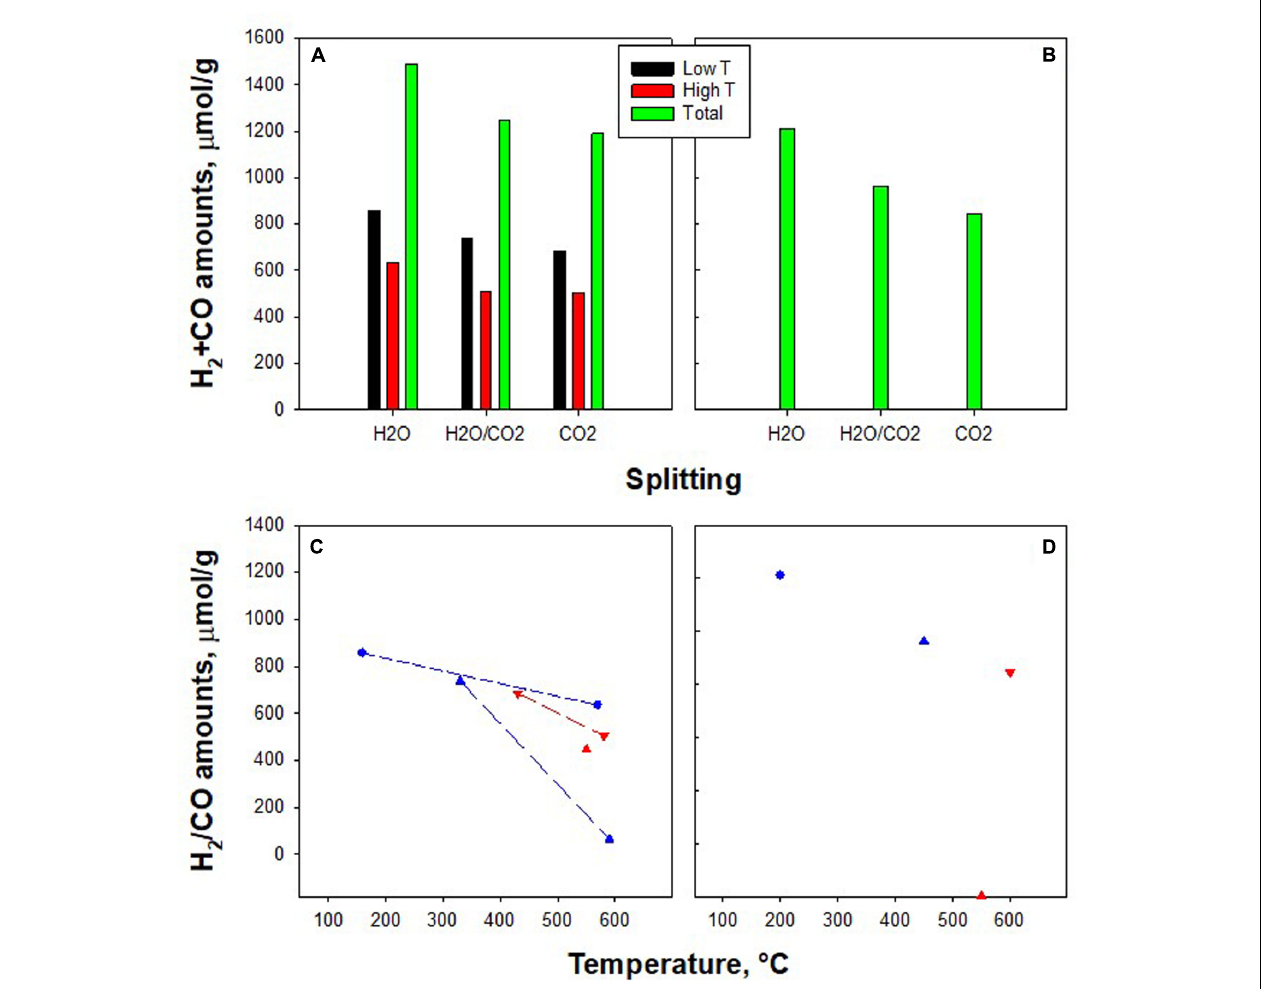
FIGURE 2 | Quantitative analysis of splitting tests under different oxidants. Partial and overall amounts of H 2 + CO on K-Fe-CeZr (A) and K-Cu-CeZr (B) ; H 2 (blue symbols) and CO (red symbols) amounts during H 2 O splitting ( ) co-splitting ( (cid:78) ), and CO 2 splitting ( (cid:72) ) on K-Fe-CeZr (C) and K-Cu-CeZr (D) (cid:32)